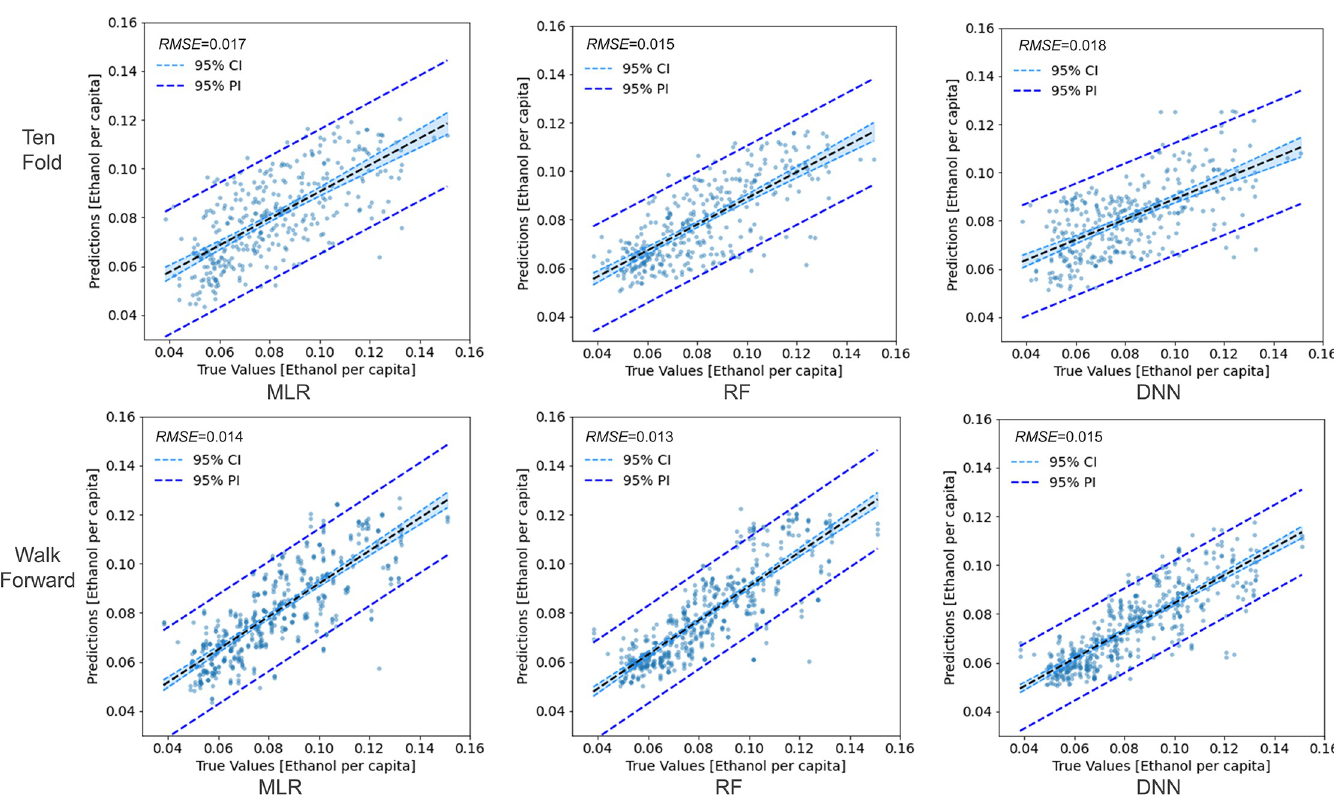
Fig 12. Performances of the three machine learning models based on ten-fold cross-validation and walk-forward validation: Multiple linear regression (MLR), random forest (RF), and a deep neural network (DNN).